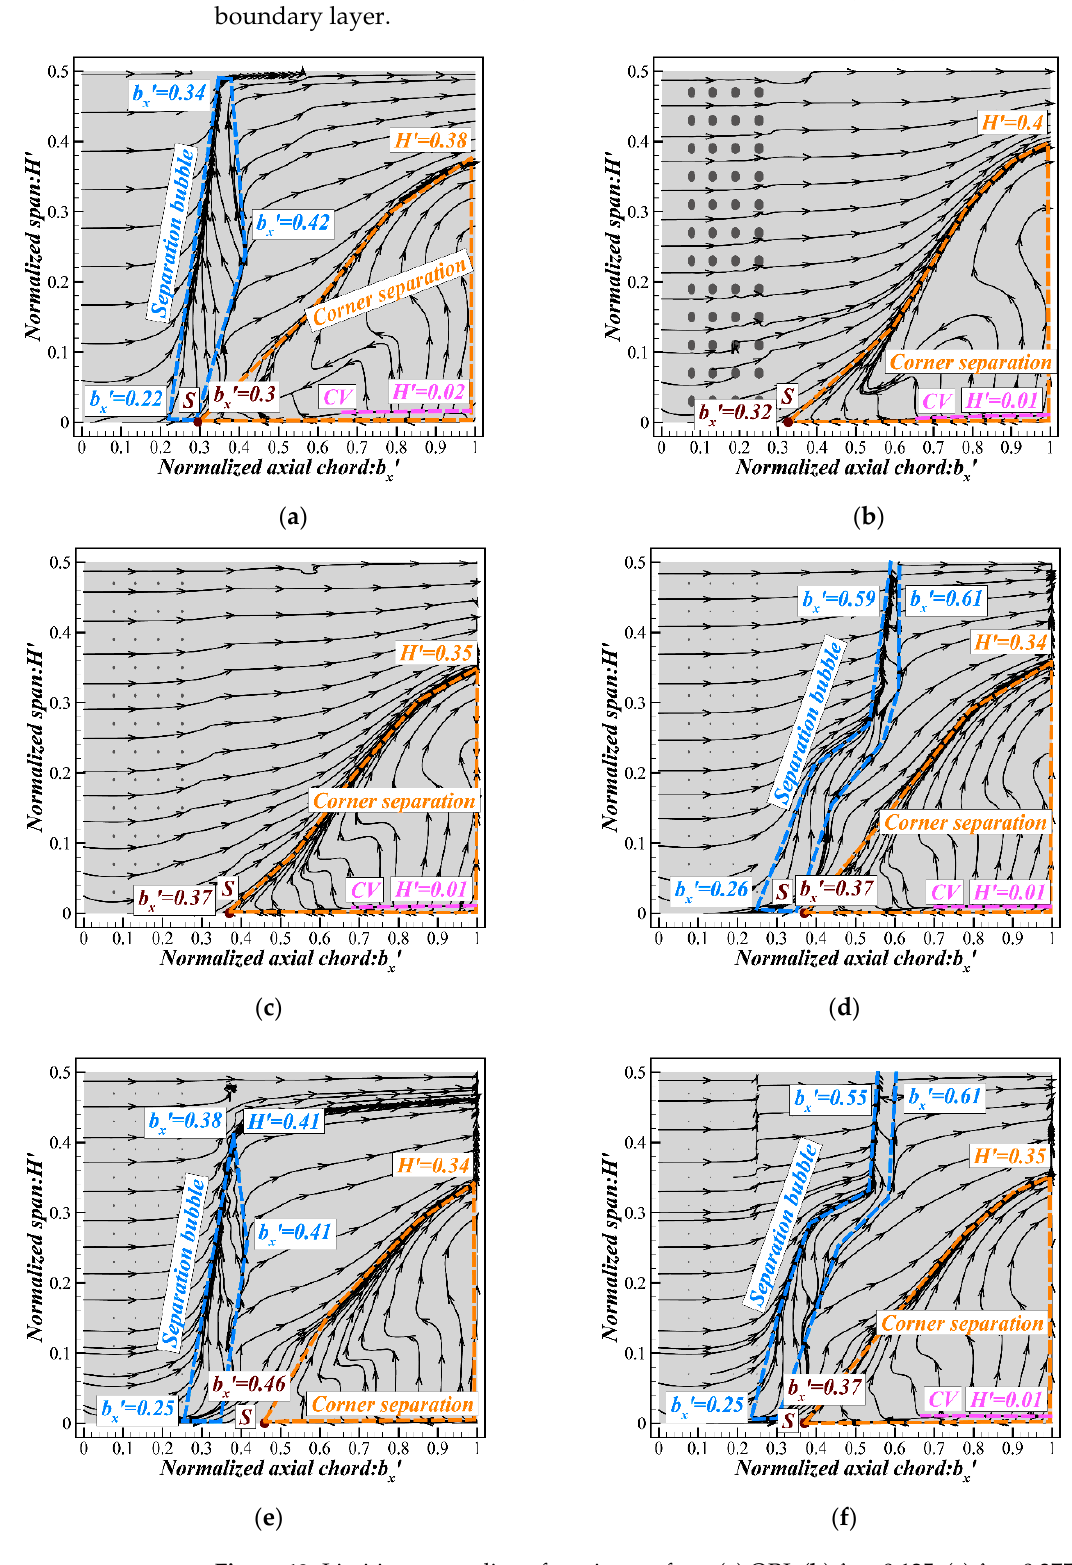
( f ) Figure 12. Three-dimensional flow near the suction surface and the end wall. ( a ) ORI; ( b ) 𝜆 = 0.125 ; ( c ) 𝜆 = 0.375 ; ( d ) 𝜆 = 0.5 ; ( e ) 𝜆 = 0.625 ; ( f ) 𝜆 = 0.875 . Figure 13 shows the limiting streamline on the suction surface, which mainly shows three flow structures, including the laminar separation bubble (LSB), corner separation and the wall corner vortex (CV) inside. The CV was weakened by the concave surface, which could confirm that the height of the projection of CV on the suction surface was reduced from 0.02 to 0.01, even disappearing at 𝜆 = 0.625 . The inferior arc schemes ( 𝜆 = 0.125 , 0.375) eliminated LSB. After 𝜆 ≥ 0.5 , the LSB was weakened but still existed, and the weakening begins from the middle part of blade. The LSB with 𝜆 = 0.625 could not